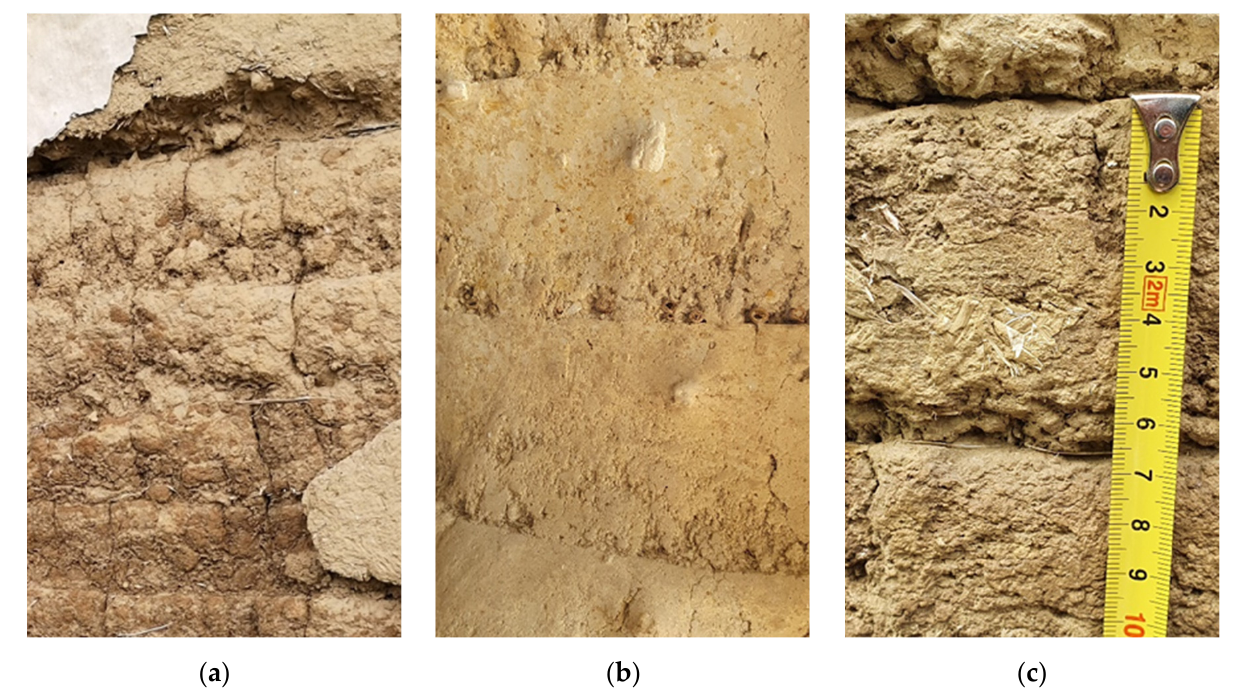
Figure 1. Photographs of traditional rammed earth walls from the area of eastern Croatia in the locations of: ( a ) Č eminac (outer wall); ( b ) Aljmaš (inner wall); ( c ) Aljmaš (outer wall). Laborel-Préneron et al. [16] group natural fibers into: cereal straw, wood aggregates,